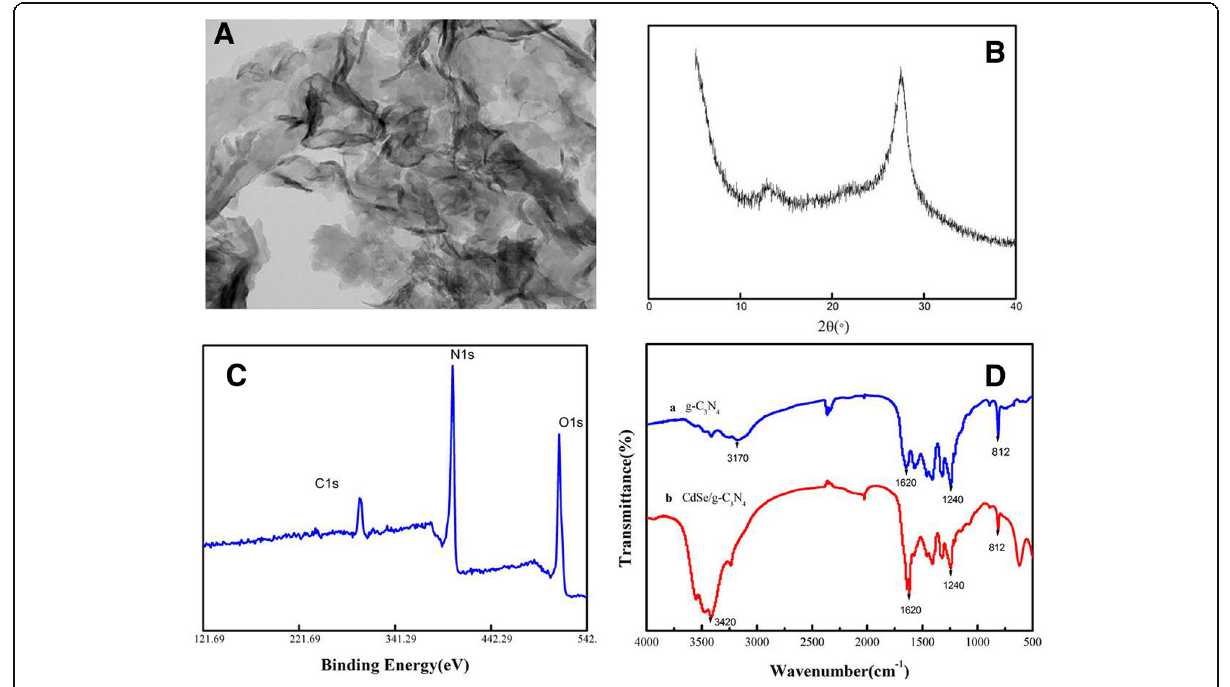
Fig. 2 Characterization of the as-prepared g-C 3 N 4 nanosheet. a TEM image. b XRD image. c XPS spectrum. d FTIR